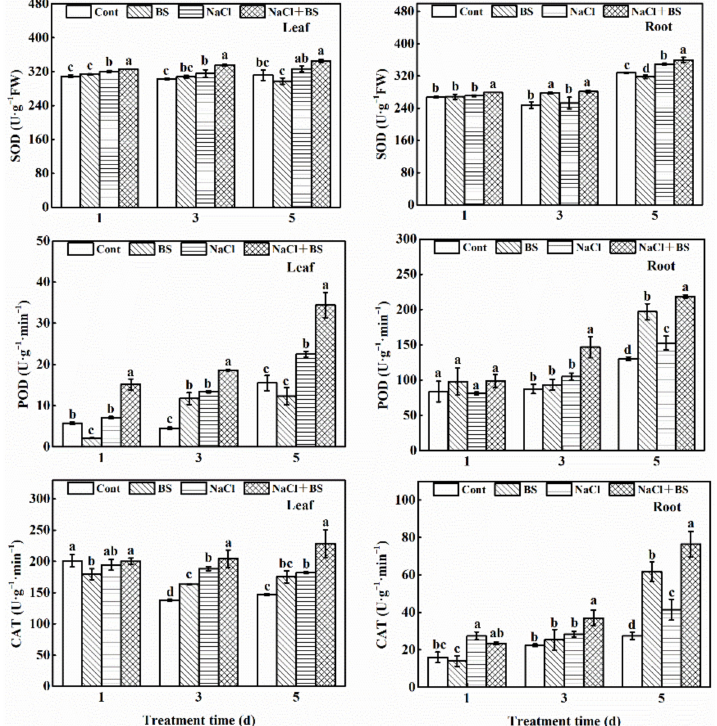
Figure 7. Effect of B. cereus on the antioxidant enzyme activities of cucumber seedlings under salt stress. Bars represent standard errors. Different letters indicate a significant difference in the same parameter between treatments at p <